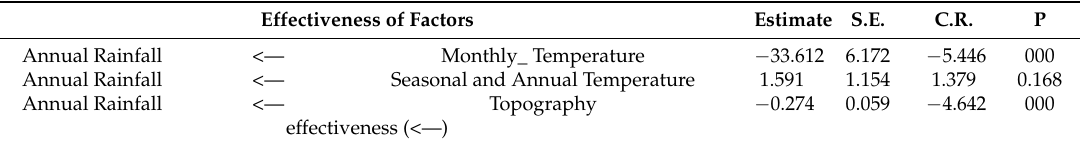
Table 6. Significant effectiveness of factors on annual rainfall.